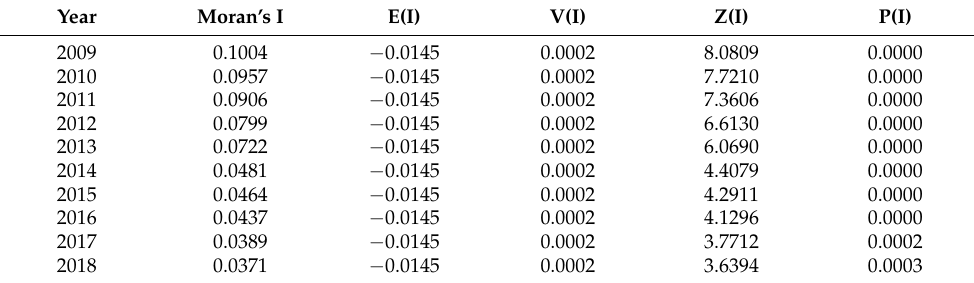
Table 2. Moran’s I of HQD of seven urban